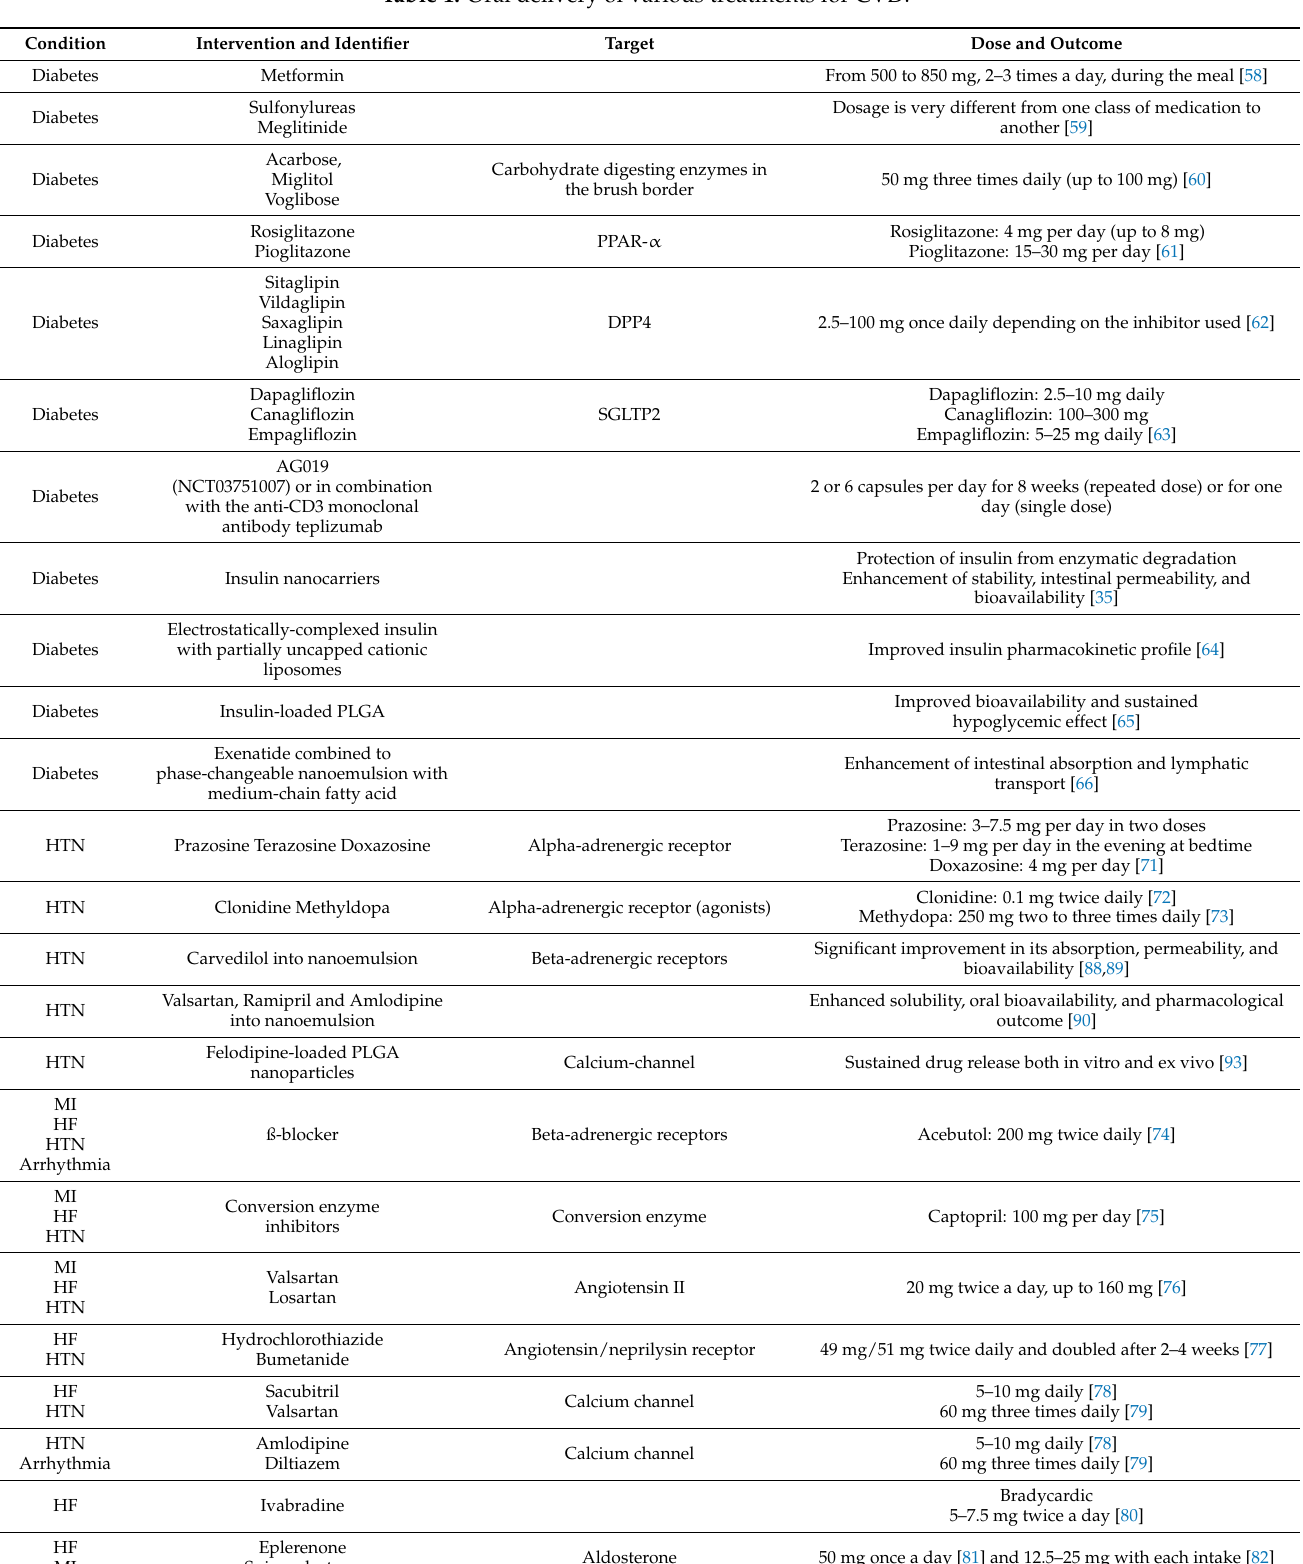
Table 1. Oral delivery of various treatments for